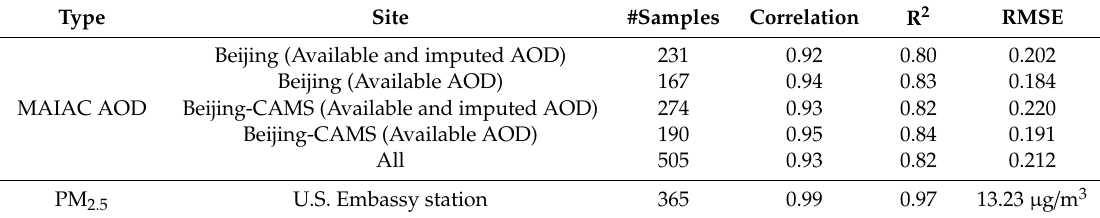
Table 3. Validation of residual deep network with AERONENT AOD (MAIAC AOD) and U.S. Embassy monitoring station (PM 2.5